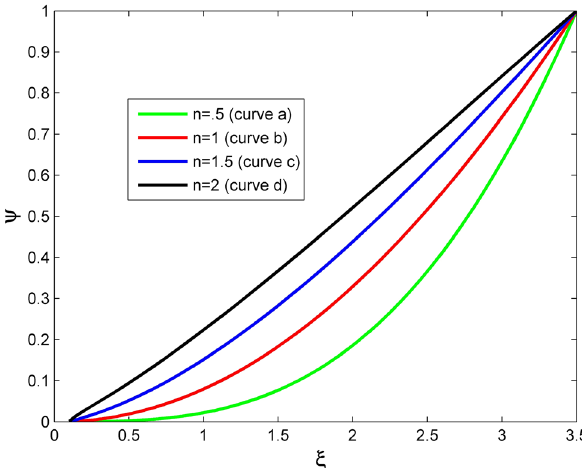
Fig. 5 Graphs between ξ and ψ